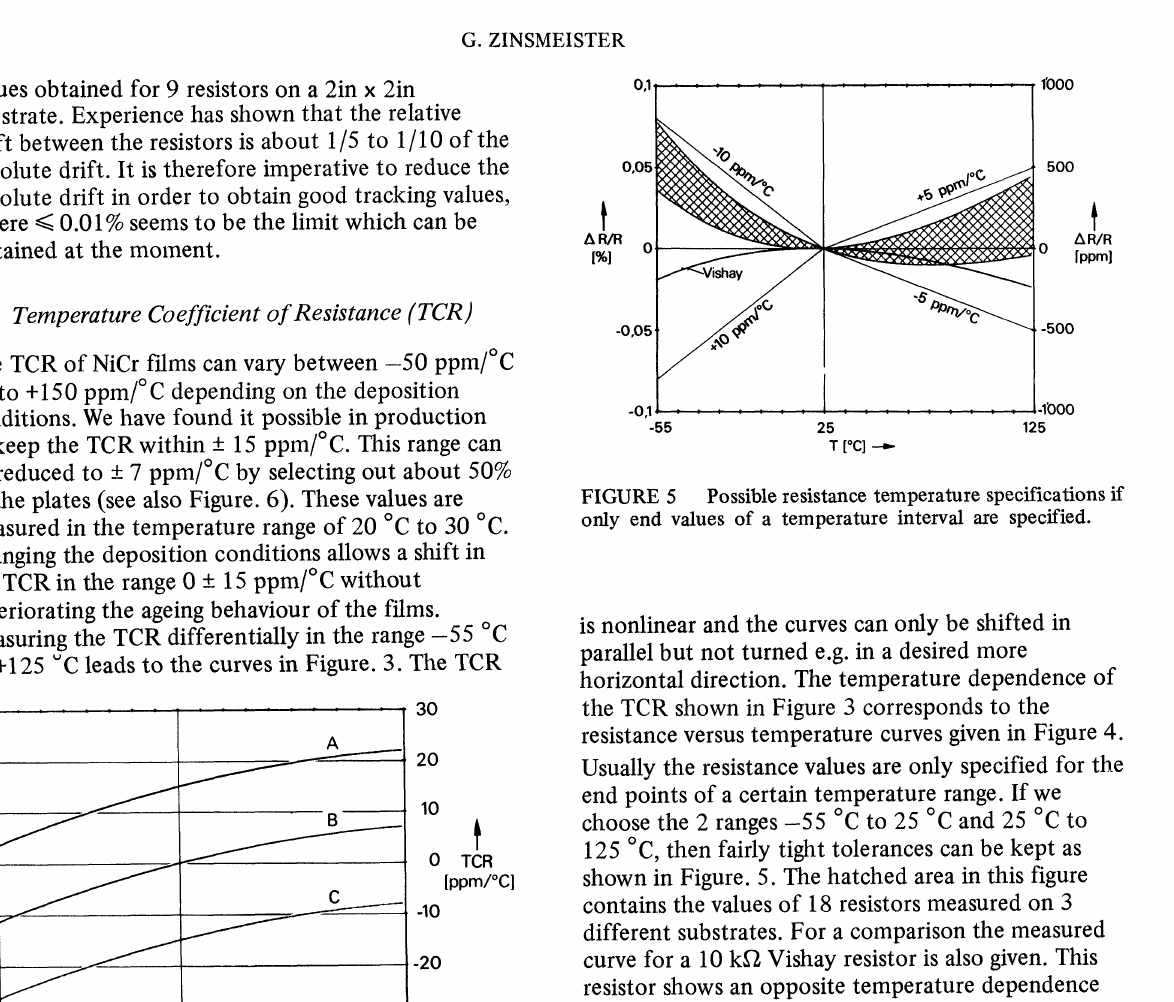
TCR as a function of temperature for 3 different NiCr Films A, B and C.